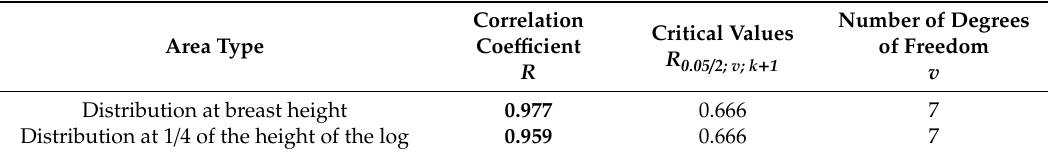
Table 8. Two-sided tests of the significance of correlation coefficients between average densities across the entire birch log and average densities across the cross-section at breast height and ¼ of the height of the birch log (at the significance level p = 0.05).